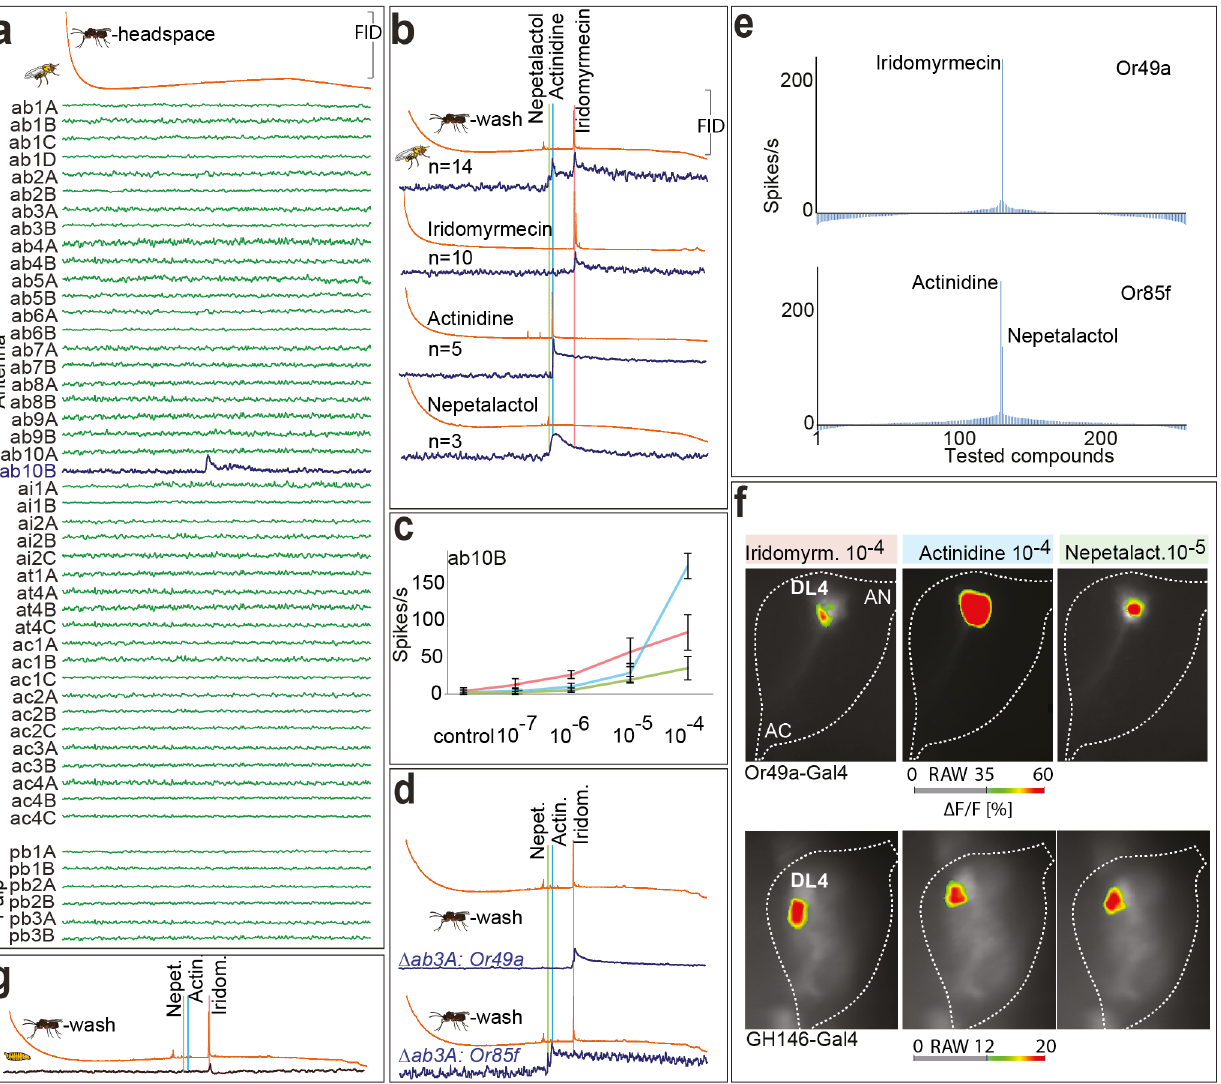
Fig 2. The ab10B neuron detects parasitoid odors. ( A ) Example spike traces of GC-coupled SSR with all D . melanogaster OSN types and the headspace of L . boulardi (note that the amount of odors within headspace is too low to be detected and analyzed by GC, but is still detected by ab10B). FID, flame ionization detector. ( B ) GC-coupled SSR with the ab10B neuron and the wash of L . boulardi (1st panel), as well as the identified active compounds (2nd – 4th panel). ( C ) SSR dose-response curves of the ab10B neuron tested with active compounds. ( D ) GC-coupled SSR with mutant ab3A neuron ectopically expressing either Or49a or Or85f. Blue, green, and red lines indicate active compounds. ( E ) Tuning breadths of Or49a and Or85f. 232 odorants are displayed along the x -axis according to strengths of responses they elicit from each receptor. Odorants eliciting strongest responses are placed near the center of distribution. Negative values indicate inhibitory responses. For a list of compounds, see S4 Fig; for raw data see S1 Data. ( F ) Identification of glomeruli activated by parasitoid odors (-)-iridomyrmecin, ( R )-actinidine, and nepetalactol (a mixture of 1S4aR7R7aS, 1R4aS7S7aS-nepetalactol and their enantiomers). 1st to 3rd columns, false color-coded images showing odorant-induced calcium-dependent fluorescence changes in OSNs expressing Or49a or PNs labeled by GH-146-Gal4 at the antennal lobe (AL) level. Flies express UAS-GCaMP3.0 under control of either Or49a-Gal4, or the GH146-Gal4 driver line. ( G ) GC-coupled extracellular recordings from larval dorsal organ and wash of L . boulardi . (for more GC-SSR traces of wildtype ab10B neurons and mutant ab3A neurons expressing Or49a or Or85f see S3 Fig)